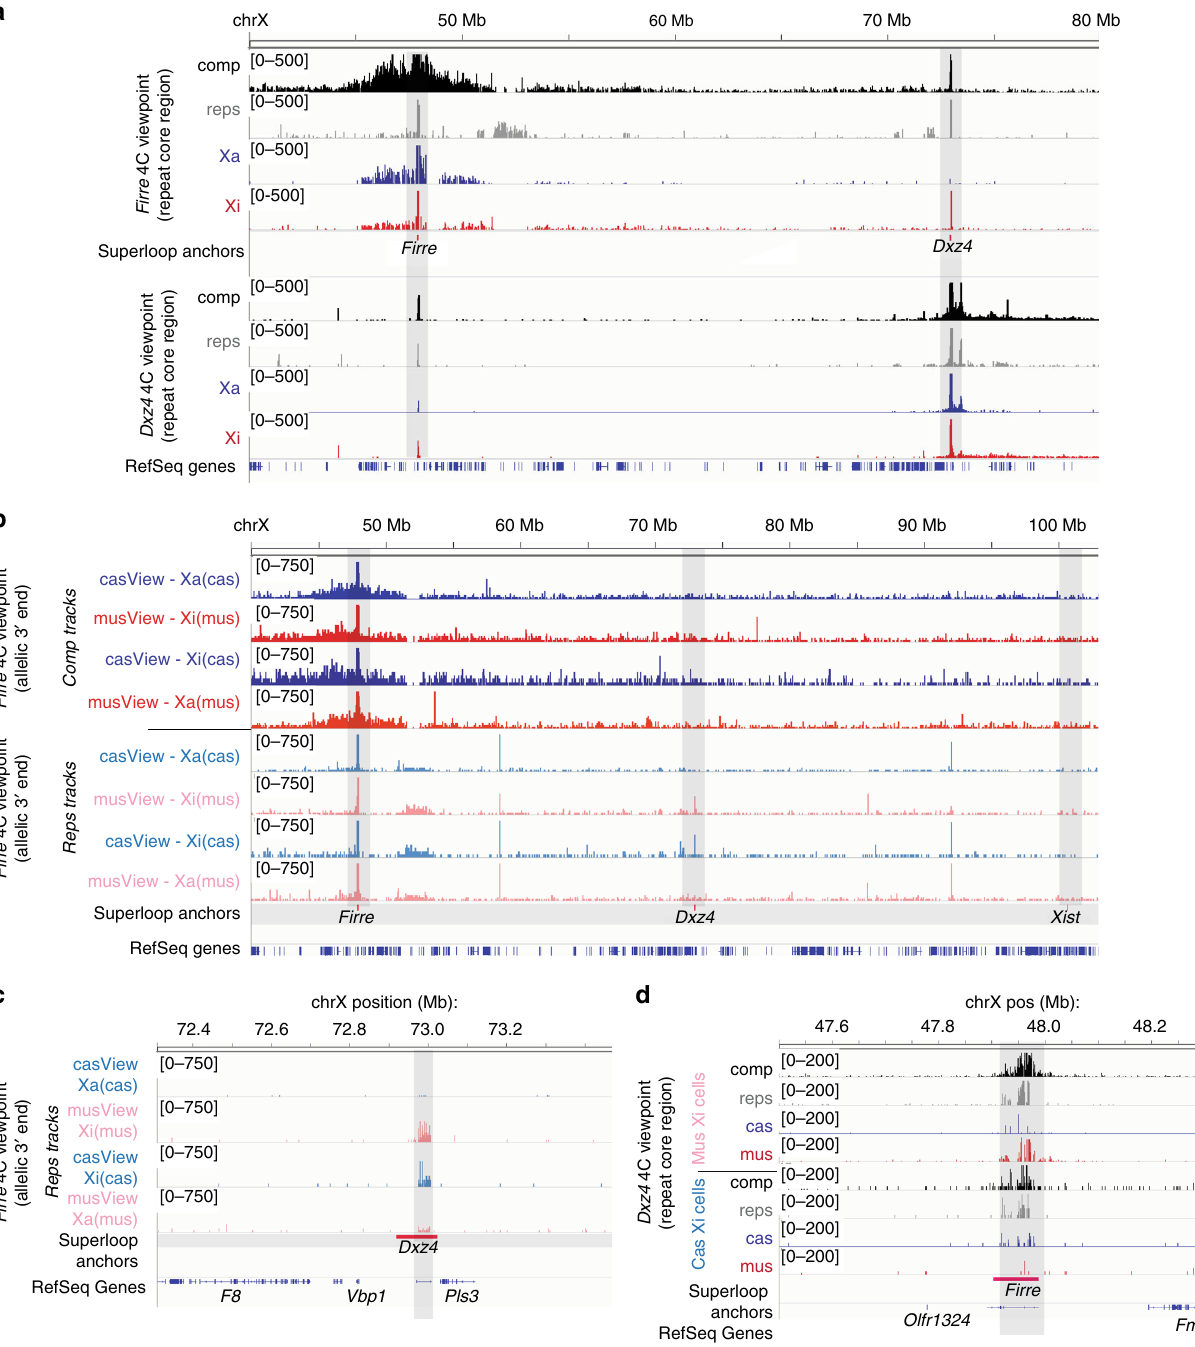
Fig. 4 Dxz4, Firre , and Xi-speci fi c superloops. a Reciprocal interaction between Dxz4 and Firre in post-XCI fi broblasts. Top: 4C interaction pro fi les with the core of the Firre tandem repeat as the viewpoint. Bottom: 4C interaction pro fi les with the core of the Dxz4 tandem repeat as the viewpoint. Black: all unique reads (comp). Grey: repetitive (non-unique) reads (reps). Blue: Xa (cas)-speci fi c reads. red: Xi (mus)-speci fi c reads. Note: For all tracks and Hi-C datasets, “ comp ” ( “ complete ” ) refers to all unique reads, including non-allelic reads. “ reps ” refers to all non-unique reads. b 4C from a unique, allele-speci fi c viewpoint at the 3 ′ end of Firre in cells with either an inactive mus (cas Xa/mus Xi) or an inactive cas (cas Xi/mus Xa). Red: interaction pro fi le for unique (comp) reads on the mus allele. Blue: interaction pro fi le for unique (comp) reads on the cas allele. Pink: interaction pro fi le for non-unique (reps) reads from the mus allele. Light Blue: interaction pro fi le for non-unique (reps) reads from the cas allele. Positions of Firre , Dxz4 and Xist are shaded light grey and indicated with red bars. c 4C interaction pro fi le from a unique, allele-speci fi c viewpoint at the 3 ’ end of Firre in cells with either a mus Xi (top tracks) or a cas Xi (bottom tracks), zoomed in onto Dxz4 . Light blue: interaction pro fi le from the cas Firre viewpoint. Pink: interaction pro fi le from the mus Firre viewpoint. d 4C interaction pro fi le over Firre using the Dxz4 core viewpoint in cells either with a mus Xi (top tracks) or a cas Xi (bottom tracks). Black: all unique (comp) reads. Grey: non-unique (repetitive) reads. Blue: cas reads. Red: mus reads. Note: c and d zoom into Dxz4 and Firre respectively to better highlight the allele-speci fi c superloop interactions. The IgV browser ’ s windowing function can obscure the relative Xa:Xi interaction strength at large length scales (such as in a ), thus these zoomed views allow better comparison of the Xa:Xi